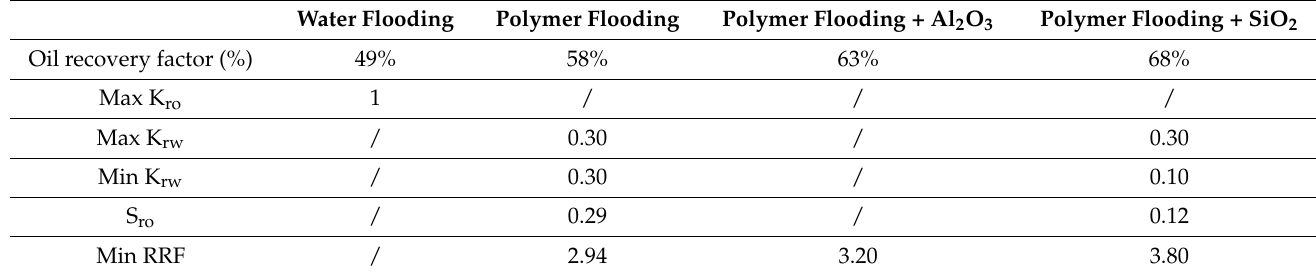
Table 2. Summary of rheology and coreflooding